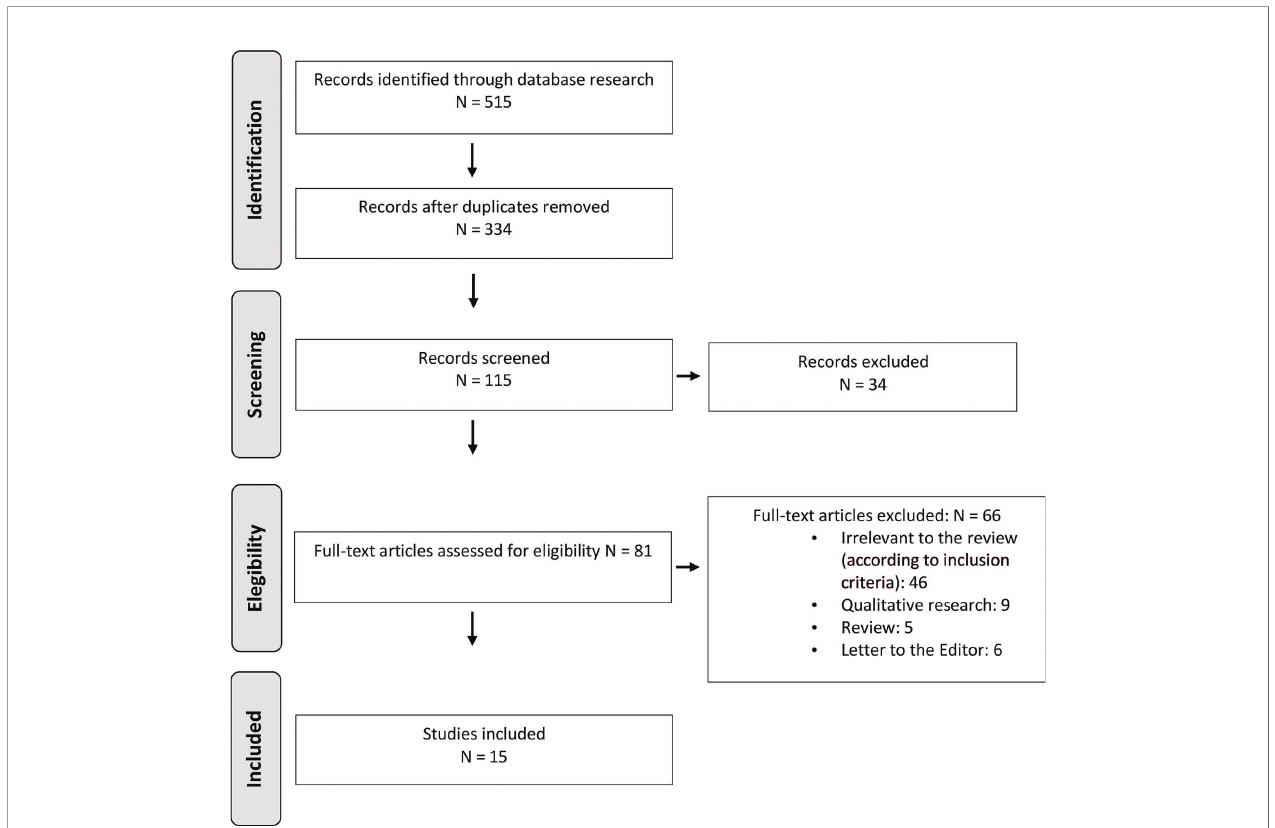
FIGURE 1 | PRISMA fl ow diagram of literature search and selection of